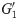
Responses of naive implementations to a step input of amplitude 10−6 nM under different values of parameter a.(A) Responses of G1′ under a = 0.5, 1.0, 1.5. (B) Responses of G1′ under a = 4.0, 5.0, 6.0. (C) Responses of G2′ under a = 0.5, 1.0, 1.5. (D) Responses of G2′ under a = 4.0, 5.0, 6.0. (E) Responses of G3′ under a = 0.5, 1.0, 1.5. (F) Responses of G3′ under a = 4.0, 5.0, 6.0.